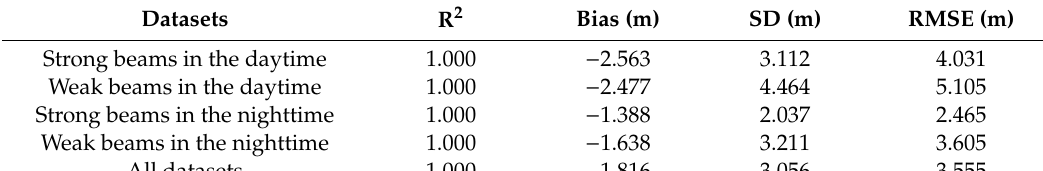
Figure 4. The qualitative results of ground surface (green line) retrieved from four different scenarios of ICESat-2 data: ( a ) strong beams of ICESat-2 in the daytime, ( b ) weak beams of ICESat-2 in the daytime, ( c ) strong beams of ICESat-2 in the nighttime, and ( d ) weak beams of ICESat-2 in the nighttime. Table 1. The statistical errors of ground elevation using four different scenarios of ICESat-2 data. Table 1. The statistical errors of ground elevation using four di ff erent scenarios of ICESat-2 data.